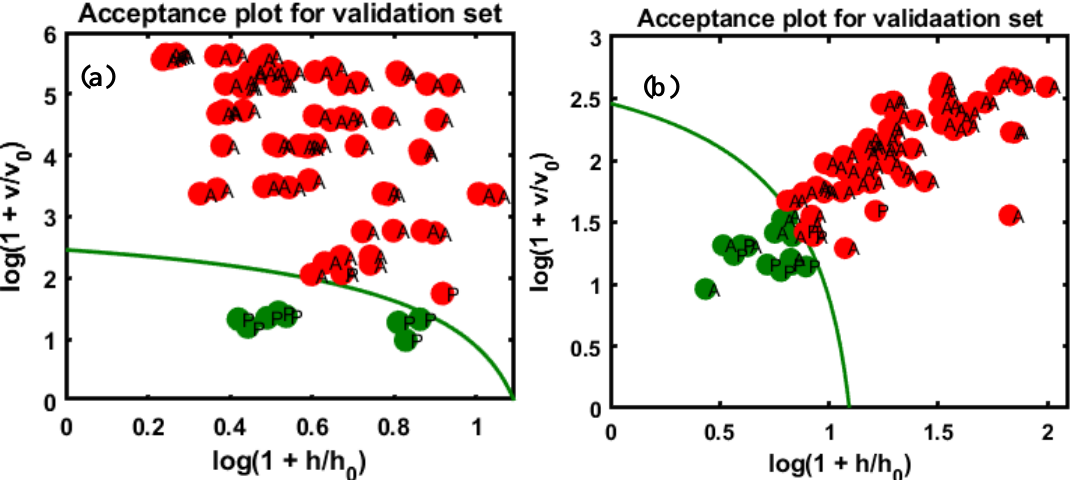
Figure 9. Predictive performance of the model based on the chi-square test determined by applying the DD-SIMCA method to the two unknown sets of data (external validation sets), ( a ) adulterated almond with apricot and ( b ) adulterated almond with peanuts.